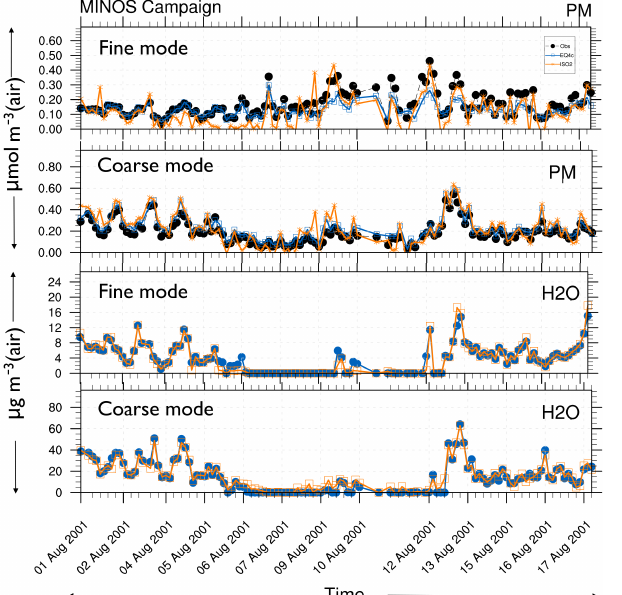
Figure 8. Observed and simulated total particulate matter [ µmolm − 3 ( air ) ] and the predicted associated water mass [ µgm − 3 ( air ) ] for the observed aerosol fine and coarse modes; EQSAM4clim (EQ4c), ISORROPIA II (ISO2), MINOS observa- tions (black circles). This figure is extended to various other aerosol properties by Figs. S8 and S9 in the Supplement.